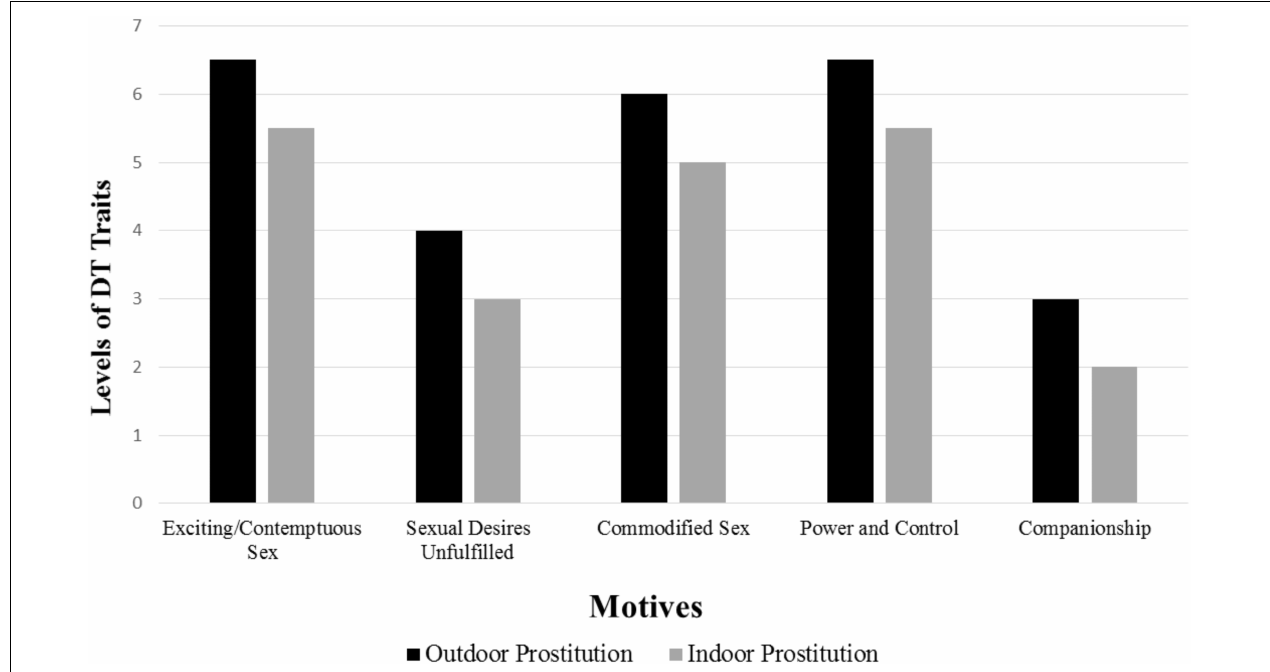
FIGURE 1 | Dark Tetrad, Motives, and Type of Prostitution Service. Hypothetical expression of Dark Tetrad traits along a scale from 1 ( low ) to 7 ( high ) among male clients of female sex works by motive and type of prostitution service.